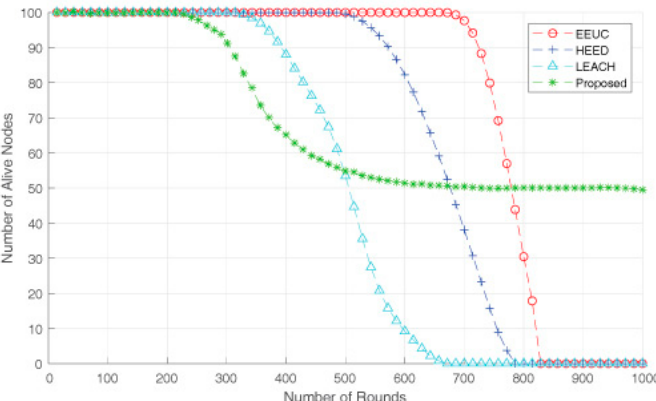
Figure 9. Performance comparison regarding the network lifetime.